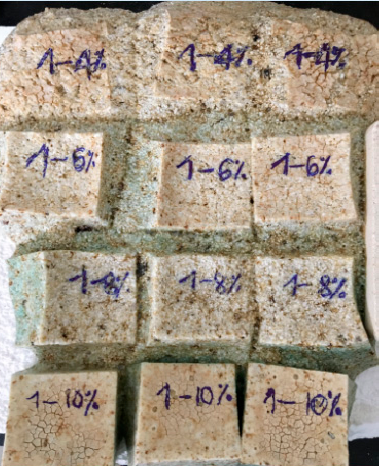
Figure 5. Photograph of AAS mortar samples after exposure to 1200 ° C .